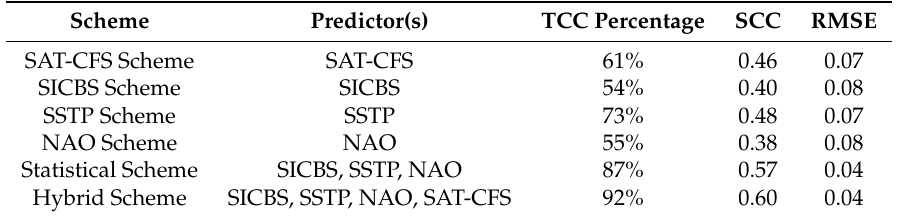
Table 1. Comparison of the cross-validation results of the prediction schemes for NDVIEA.